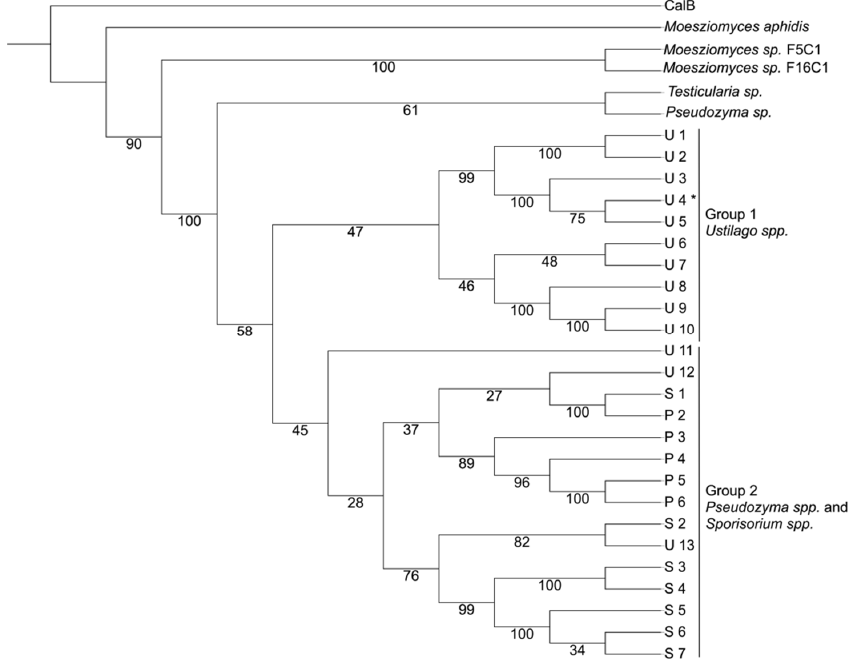
Figure 2. Phylogenetic tree of the prospected sequences with greater than 70% identity with CaLB (P41365). The groups were created selecting the branches where there were few species with high frequencies. Group 1—Ustilago spp.; and Group 2— Pseudozyma spp. and Sporosorium spp. The outgroup sequence was CaLB. The Ustilago hordei (CCF54401) is U4 and the Sporisorium scitamineum SSC39 (CP010917) is S6. The numbers represent the bootstrap values. * Lipase studied in this manuscript. Table 1. Representative lipase sequences that were identified. The Candida antarctica lipase CaLB was included in the table for comparison. The identity percentage (ID%) is in referenced to the CaLB sequence.